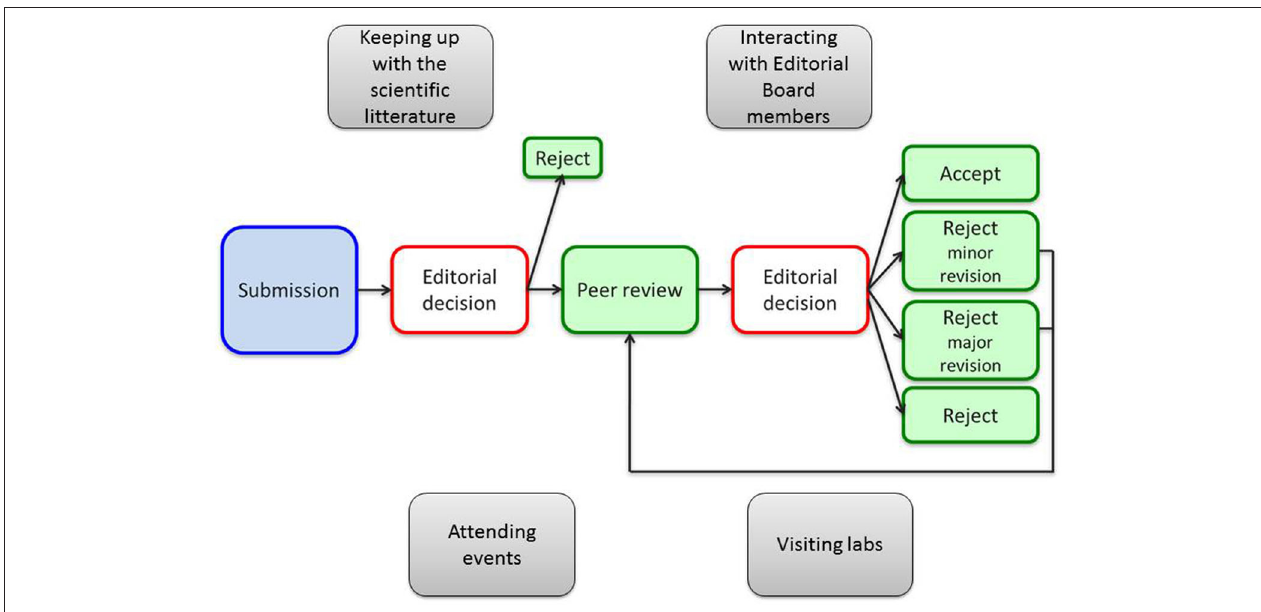
FIGURE 2 | Editorial process at Nature Research journals. Initially adapted from Verberck 2017 2 , enriched by the author with a set of complementing tasks (in gray).